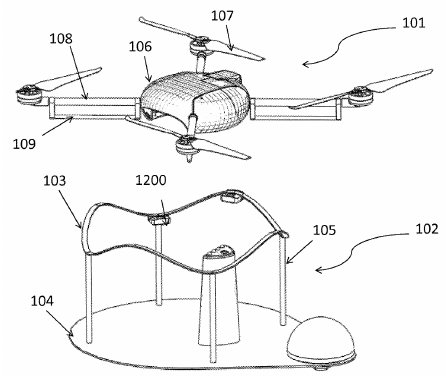
Figure 37. UAV landing system with a closed contour for positioning [92] by Kespry Inc. 101, UAV; 102, landing platform; 103, track; 104, base; 105, stands; 107, propeller of the UAV; 108, beams of the UAV frame; 109, horizontal landing supports.